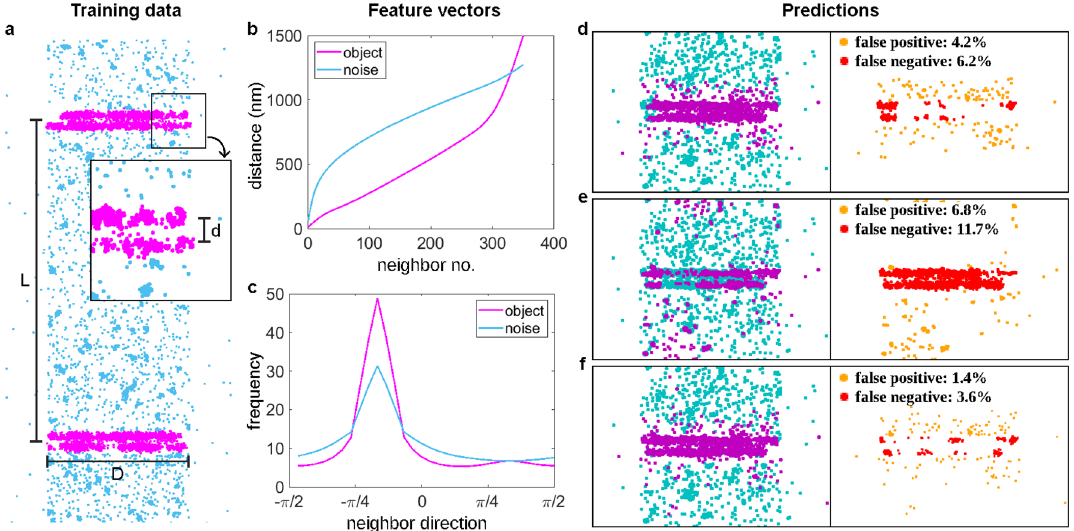
Figure 1. Training data and performance evaluation using different feature vectors. ( a ) Labelled training data generated with TestSTORM (magenta: double-line localizations, cyan: noise points) and the quantities that characterize the structure ( L = 3.4 µ m , D = 1.5 µ m , d = 120–128 nm). ( b , c ) Average feature vector values for double lines and noise localizations computed from the training data for nearest-neighbor distances ( b ) and for the smoothed distribution of the directions of the neighbors ( c ). ( d – f ) The result of neural network classification trained on different feature vectors for one simulated double-line object using the nearest neighbor distances ( d ), the neighbor directions ( e ) and both the distances and directions ( f ). On the left, the result of the classification (dark magenta: localizations classified as part of a double-line object, dark cyan: localizations classified as noise) and on the right, the misclassified localizations (yellow: noise localizations classified as double-line object points, red: double-line localizations classified as